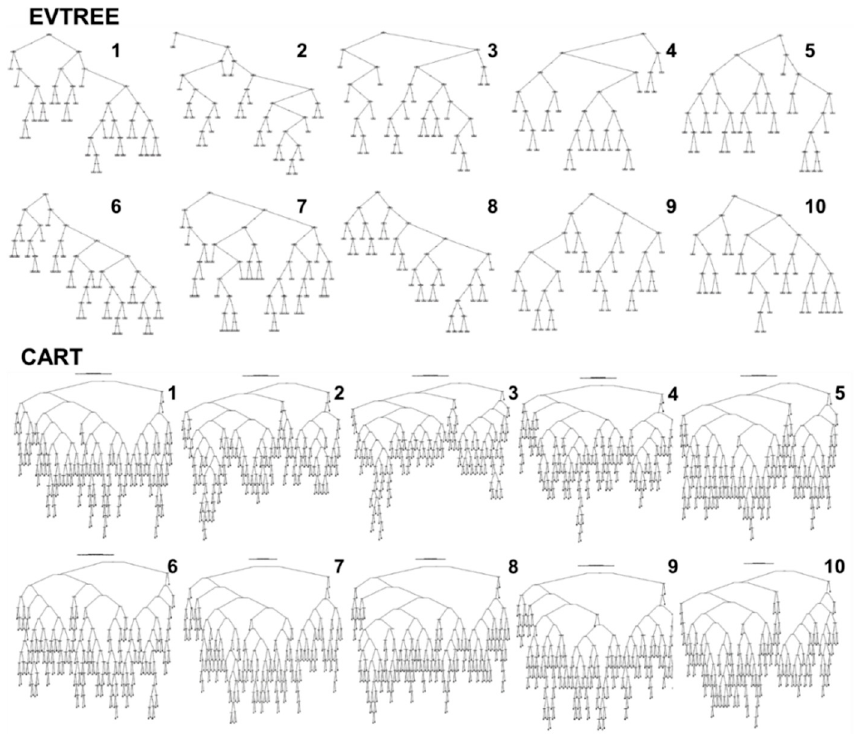
Figure 5. The appearance of the trees that were created via EVTREE and CART.